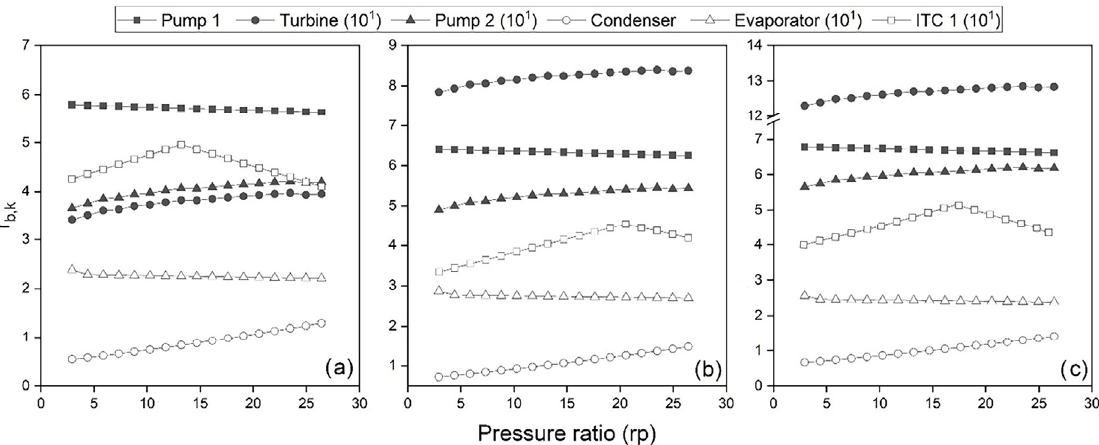
Figure 11 . Relative difference in the specific environmental impact of the components using ( a ) steel, ( b ) copper, ( c ) aluminum as a base material.